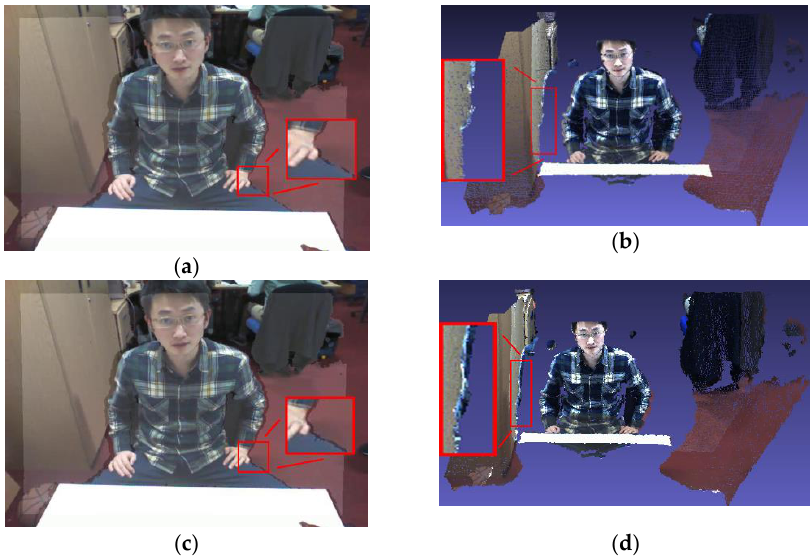
Figure 8. Joint 3D reconstruction. ( a ) and ( b ) are the overlaid depth map and the corresponding joint reconstructed 3D image by proposed method, respectively; ( c ) and ( d ) are the overlaid depth map and the corresponding joint reconstructed 3D image by Herrera’s method, respectively.